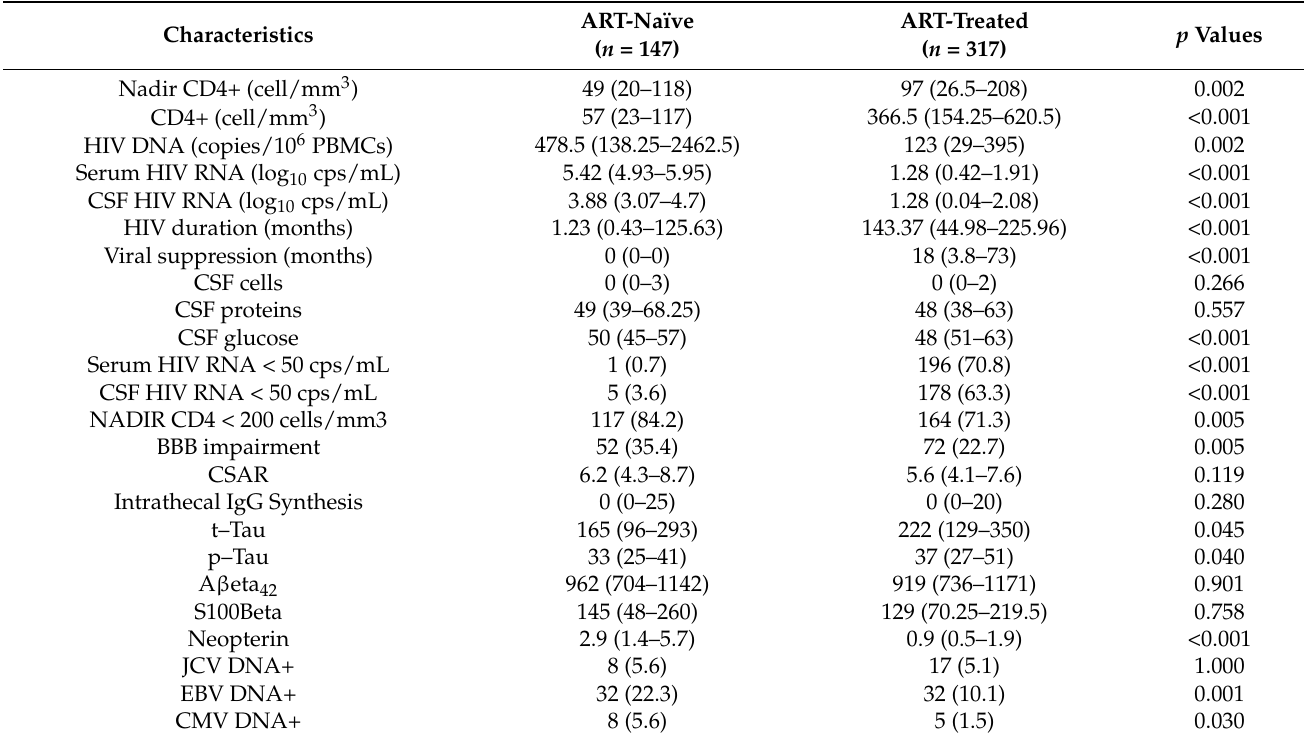
Table 3. Laboratory features and biomarkers according to treatment group. Variables were tested through Mann–Whitney (continuous variables) or Chi–square/Fisher’s exact test